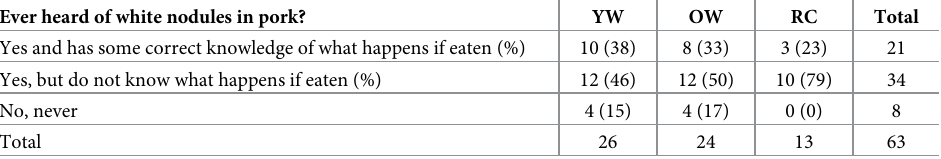
Table 5. Answers to the question “Have you ever heard of “white nodules” in pork?” from 63 informants, as in Table 4 but divided into informant groups. Ever heard of white nodules in